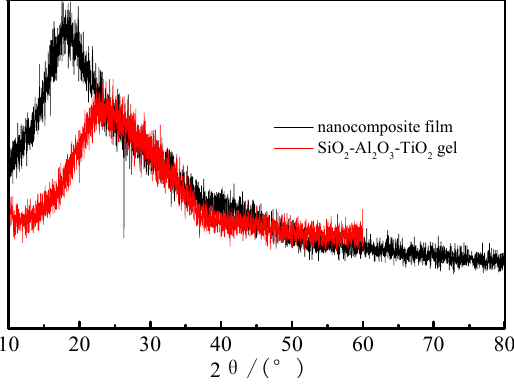
Figure 7. XRD spectra of the specimens.